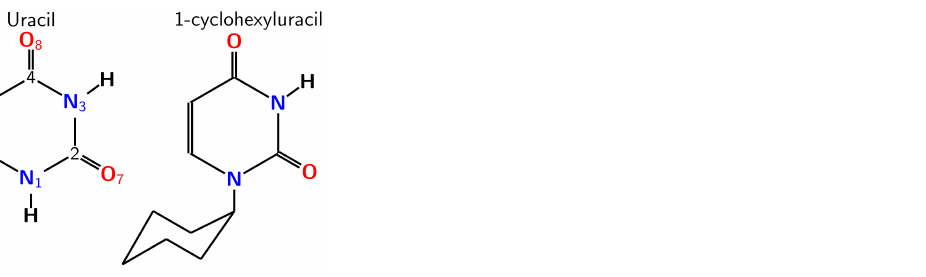
Figure 1. Molecular structure and numeration scheme of uracil and 1-cyclohexyluracil